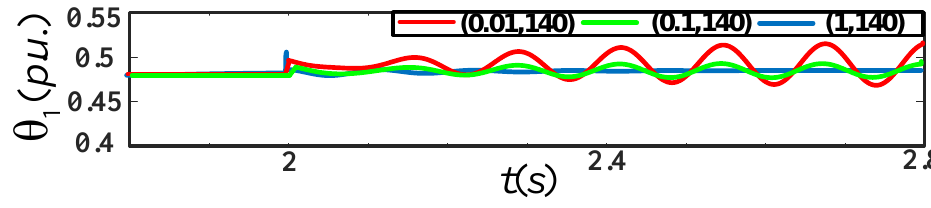
Figure 8. Time domain responses of θ of WT 1 with different control parameters of DC voltage ( k P 13 ) of WT 3.